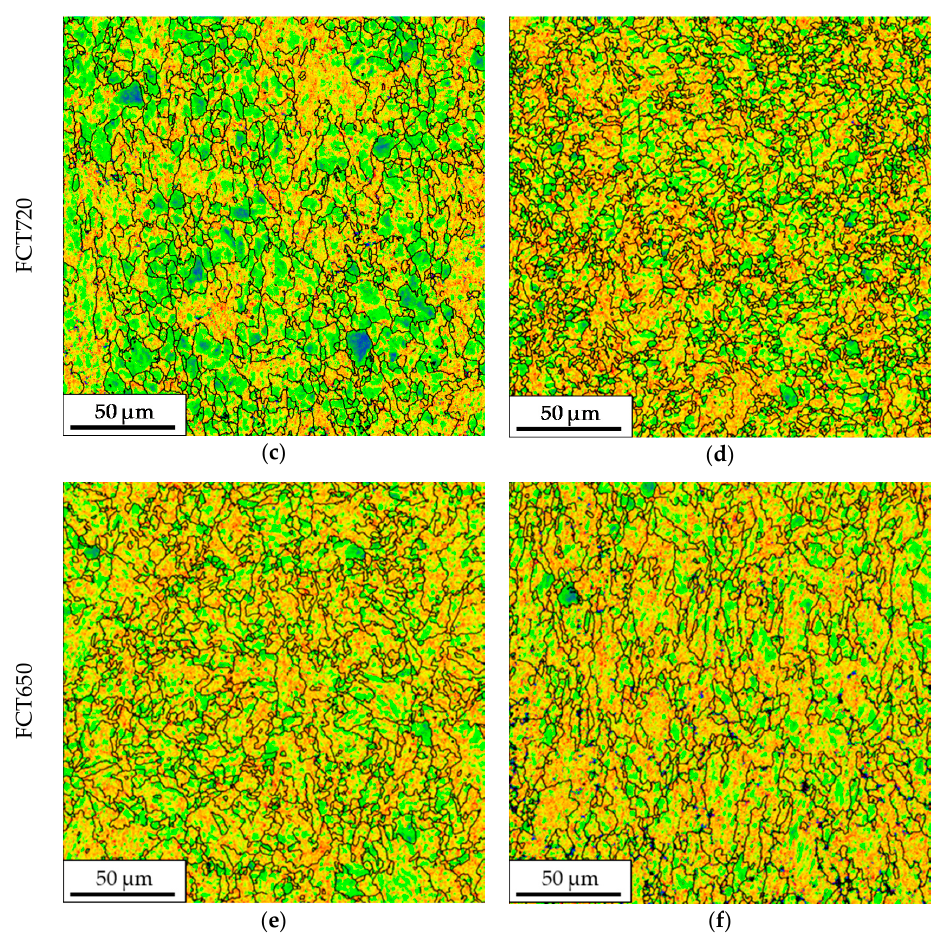
Figure 11. Kernel maps corresponding to the samples obtained before (FCT in ( a , c , e )) and after induction treatment (FCT-HT in ( b , d , f )) at different conditions: ( a , b ) FCT790 and ( c , d ) FCT720 and ( e , f ) FCT650.